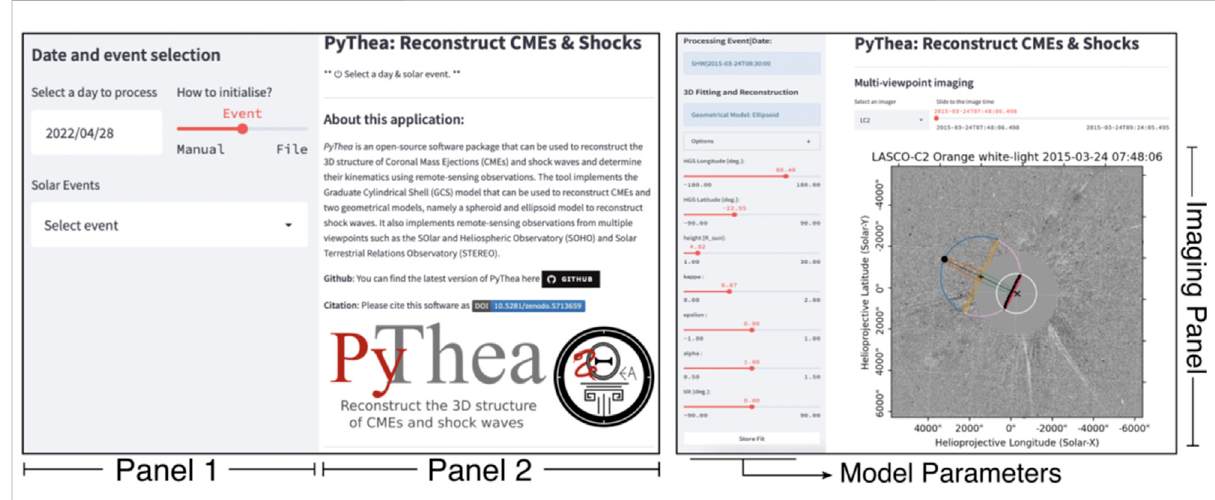
FIGURE 6 TwoviewsofPyThea ‘ swebapplication.Theleftpanelshowsthestartingpageoftheapplicationandtherightpanelshowsthemain fi